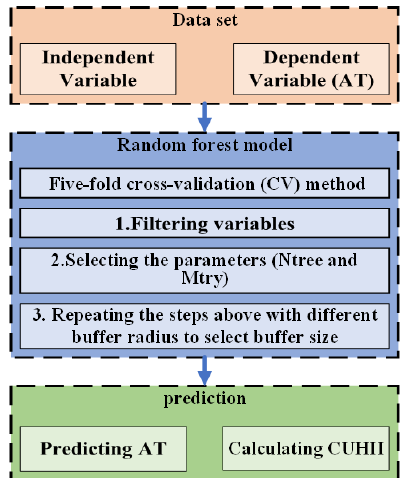
Figure 3. Flowchart for constructing the RF model and evaluating the CUHII (canopy layer urban heat